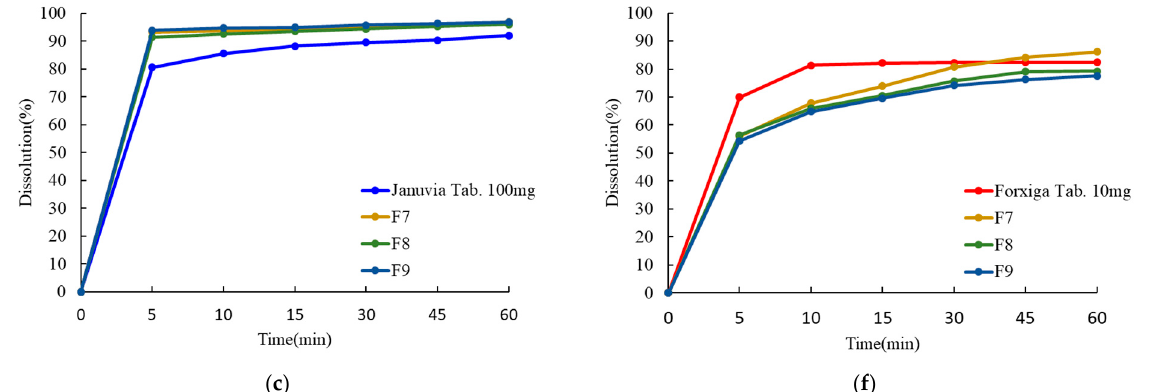
Figure 10. Dissolution profiles of the reference drug and sitagliptin-dapagliflozin FDC tablets in pH 6.8 medium ( n = 6). ( a ) Single-layer tablet of sitagliptin. ( b ) Double-layer tablet of sitagliptin. ( c ) Dry-coated tablet of sitagliptin. ( d ) Single-layer tablet of dapagliflozin. ( e ) Double-layer tablet of dapagliflozin. ( f ) Dry-coated tablet of dapagliflozin. Table 13. Similarity factor (f2) evaluated of sitagliptin phosphate monohydrate-dapagliflozin propanediol hydrate FDC tablet.